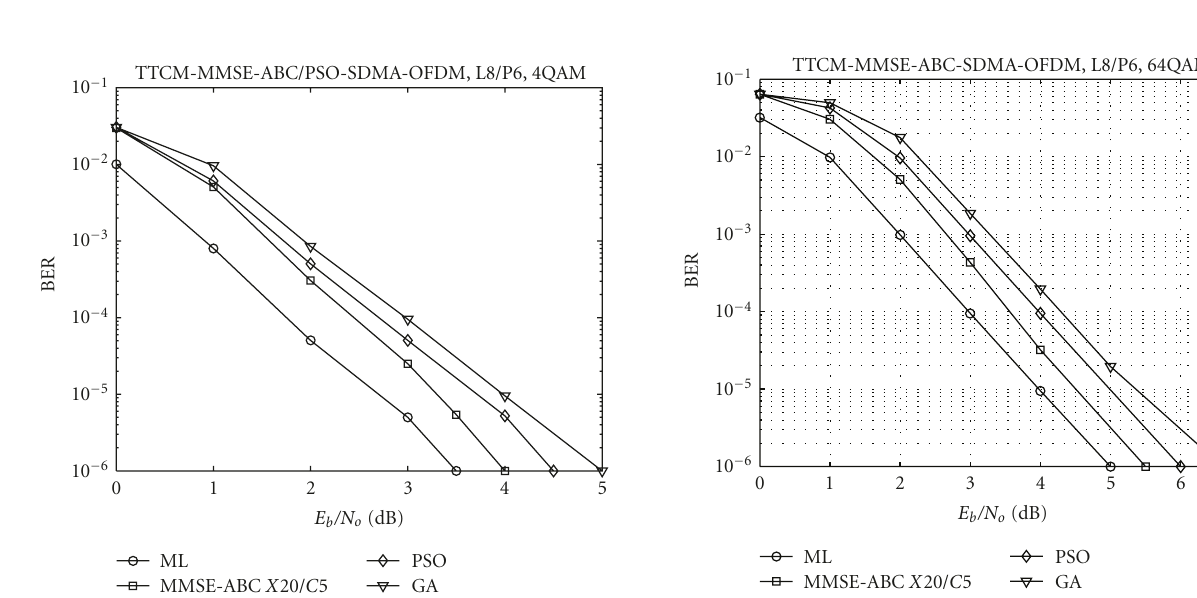
Figure 3: BER versus E b /N o performance comparison of 6 × 6 system.